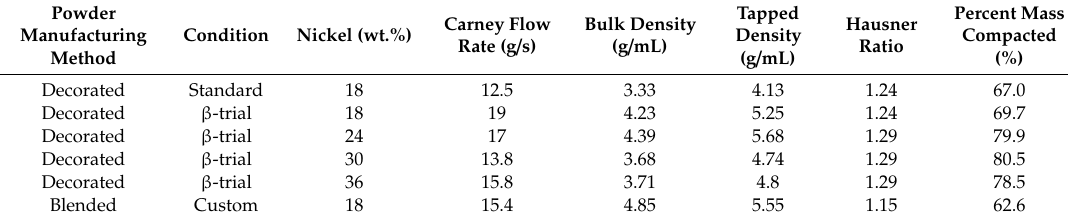
Table 3. Characterization data of evaluated